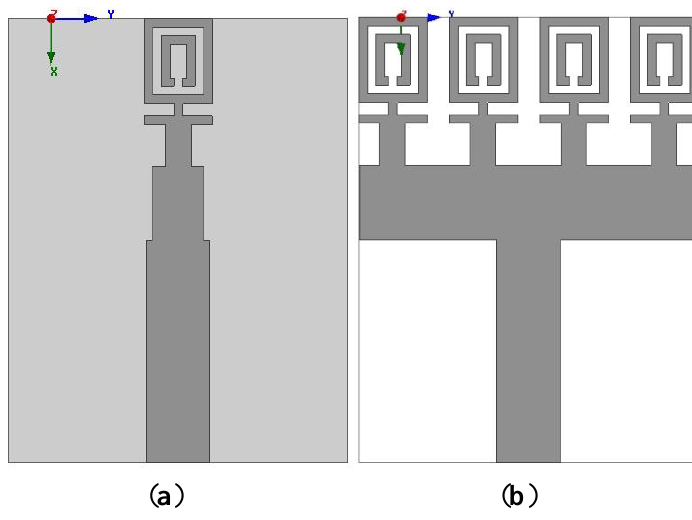
Figure 4. ( a ) One element MTM antenna and ( b ) four-element MTM antenna.